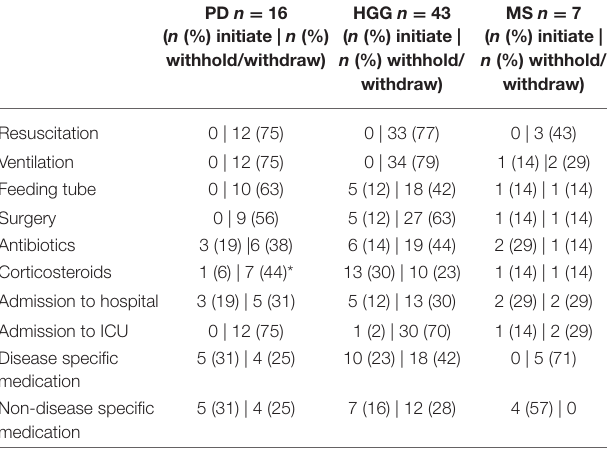
TABLE 3 | Considered treatment options per disease